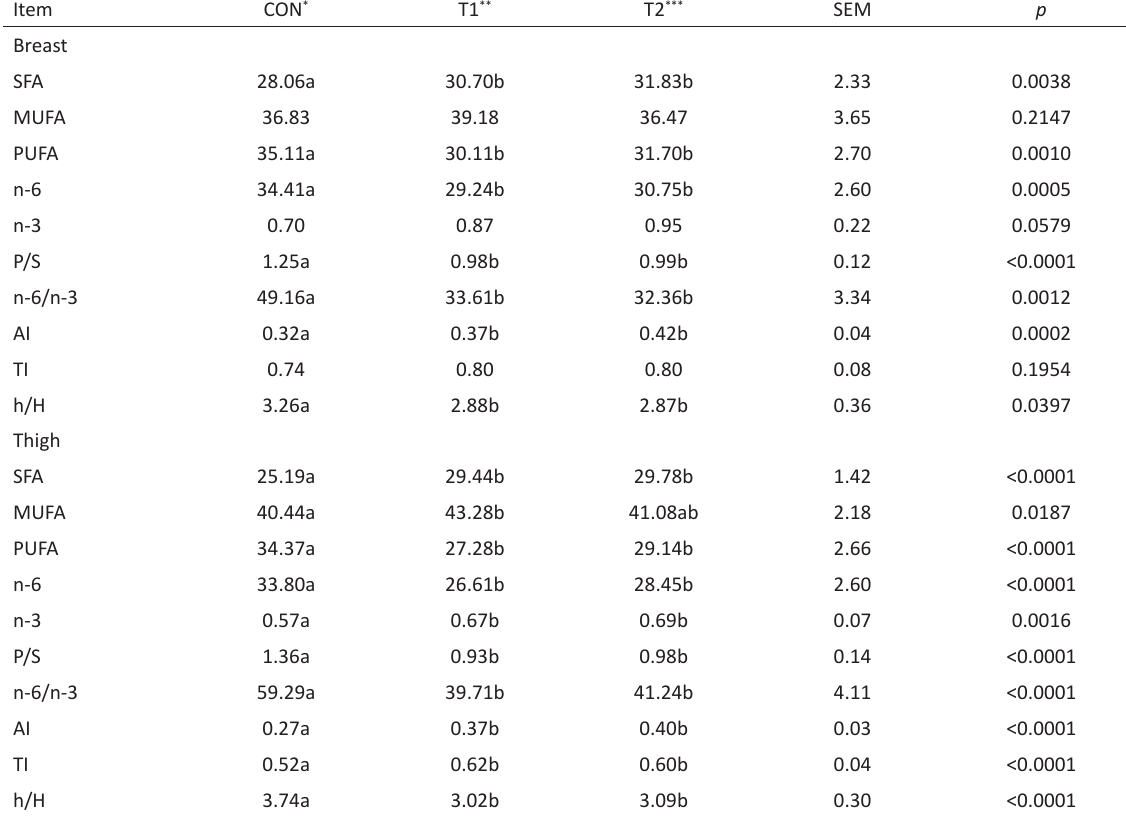
Table 7. Total content of fatty acids and lipid nutritional indices in breast and thigh meat